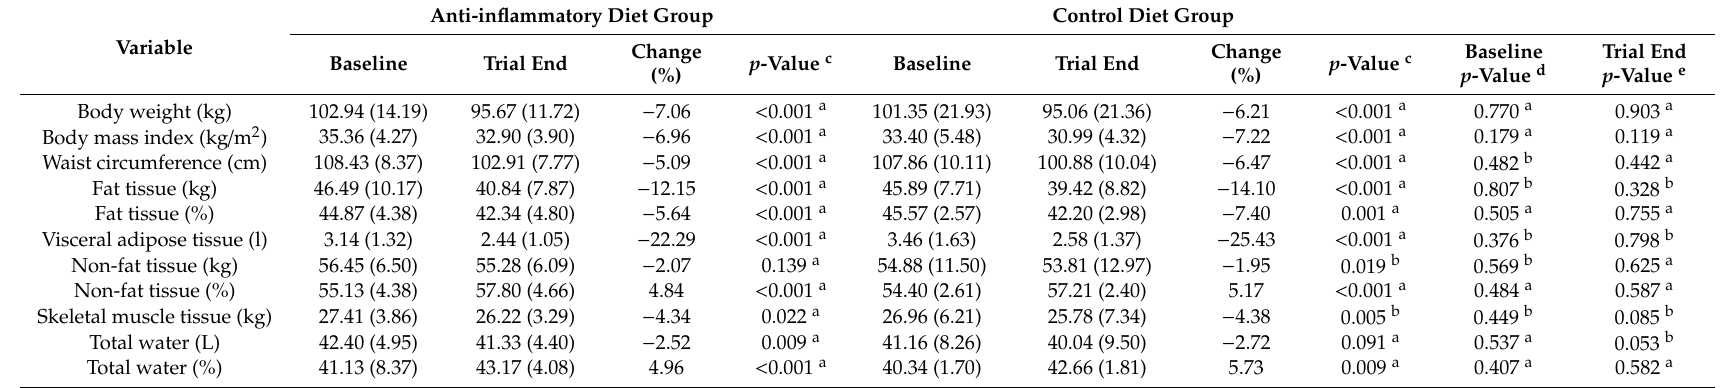
Table 3. The changes in the anthropometric and body composition